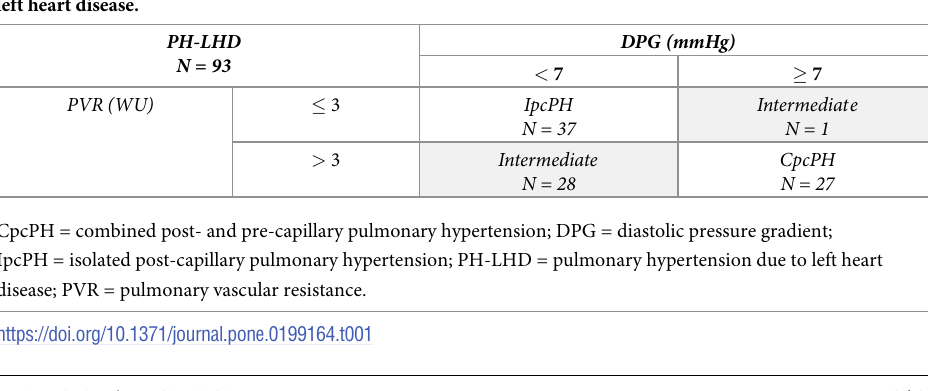
Table 1. Patients’ subdivision according to the haemodynamic classification of pulmonary hypertension due to left heart disease.